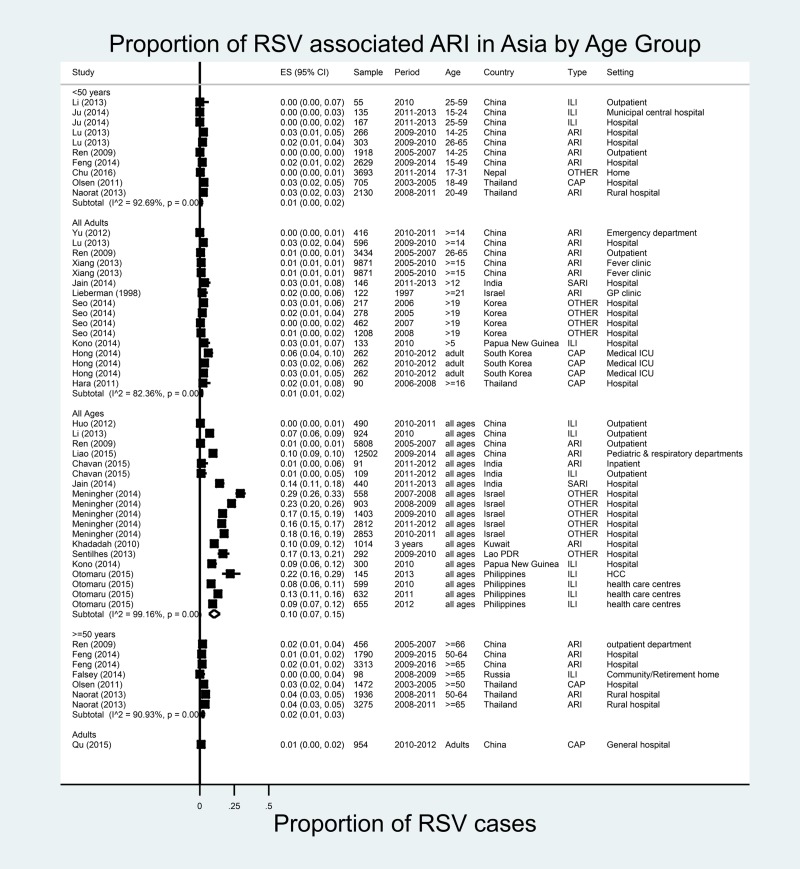
Proportion of RSV among ARI/ILI in adults in Asia.